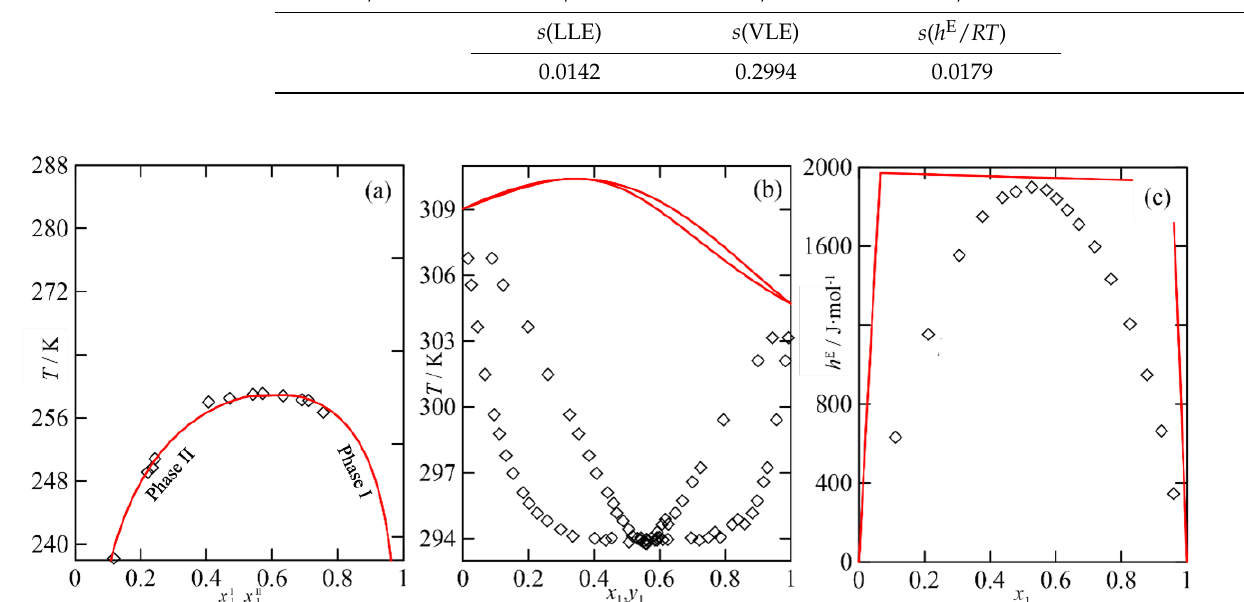
Figure 3. Estimations obtained with the NRTL model using experimental data for the binary methyl methanoate (1) + pentane (2). The classical approach ( — ) APV88 for ( a ) LLE, T vs x I VLE, T vs x 1 ,or y 1 ; ( c ) h E vs x 1 . , experimental data. (cid:51)